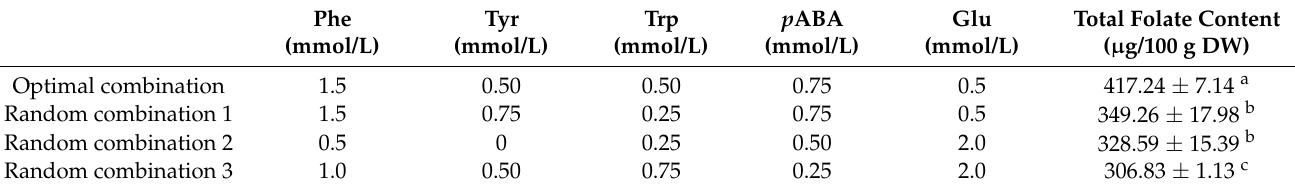
Table 2. Arrangement and result of validation trials ( n = 3).